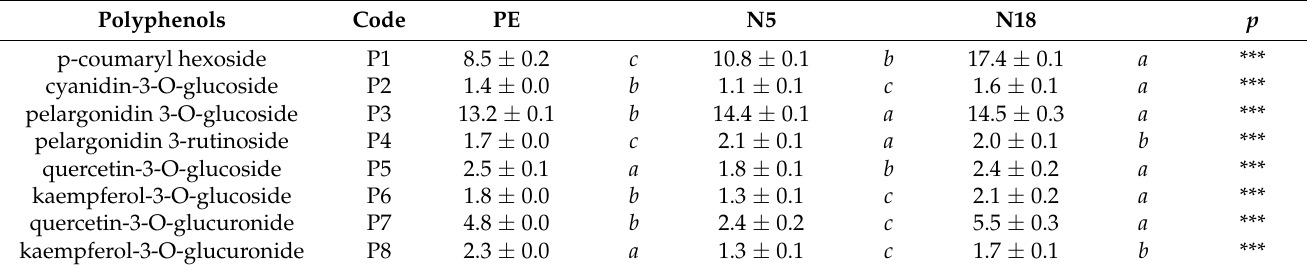
Table 5. Assignment and semi-quantitative determination of phenolic compounds (mg 100g − 1 FW) measured in strawberries cv Elide cultivated with three different mulch types (PE, N5, and